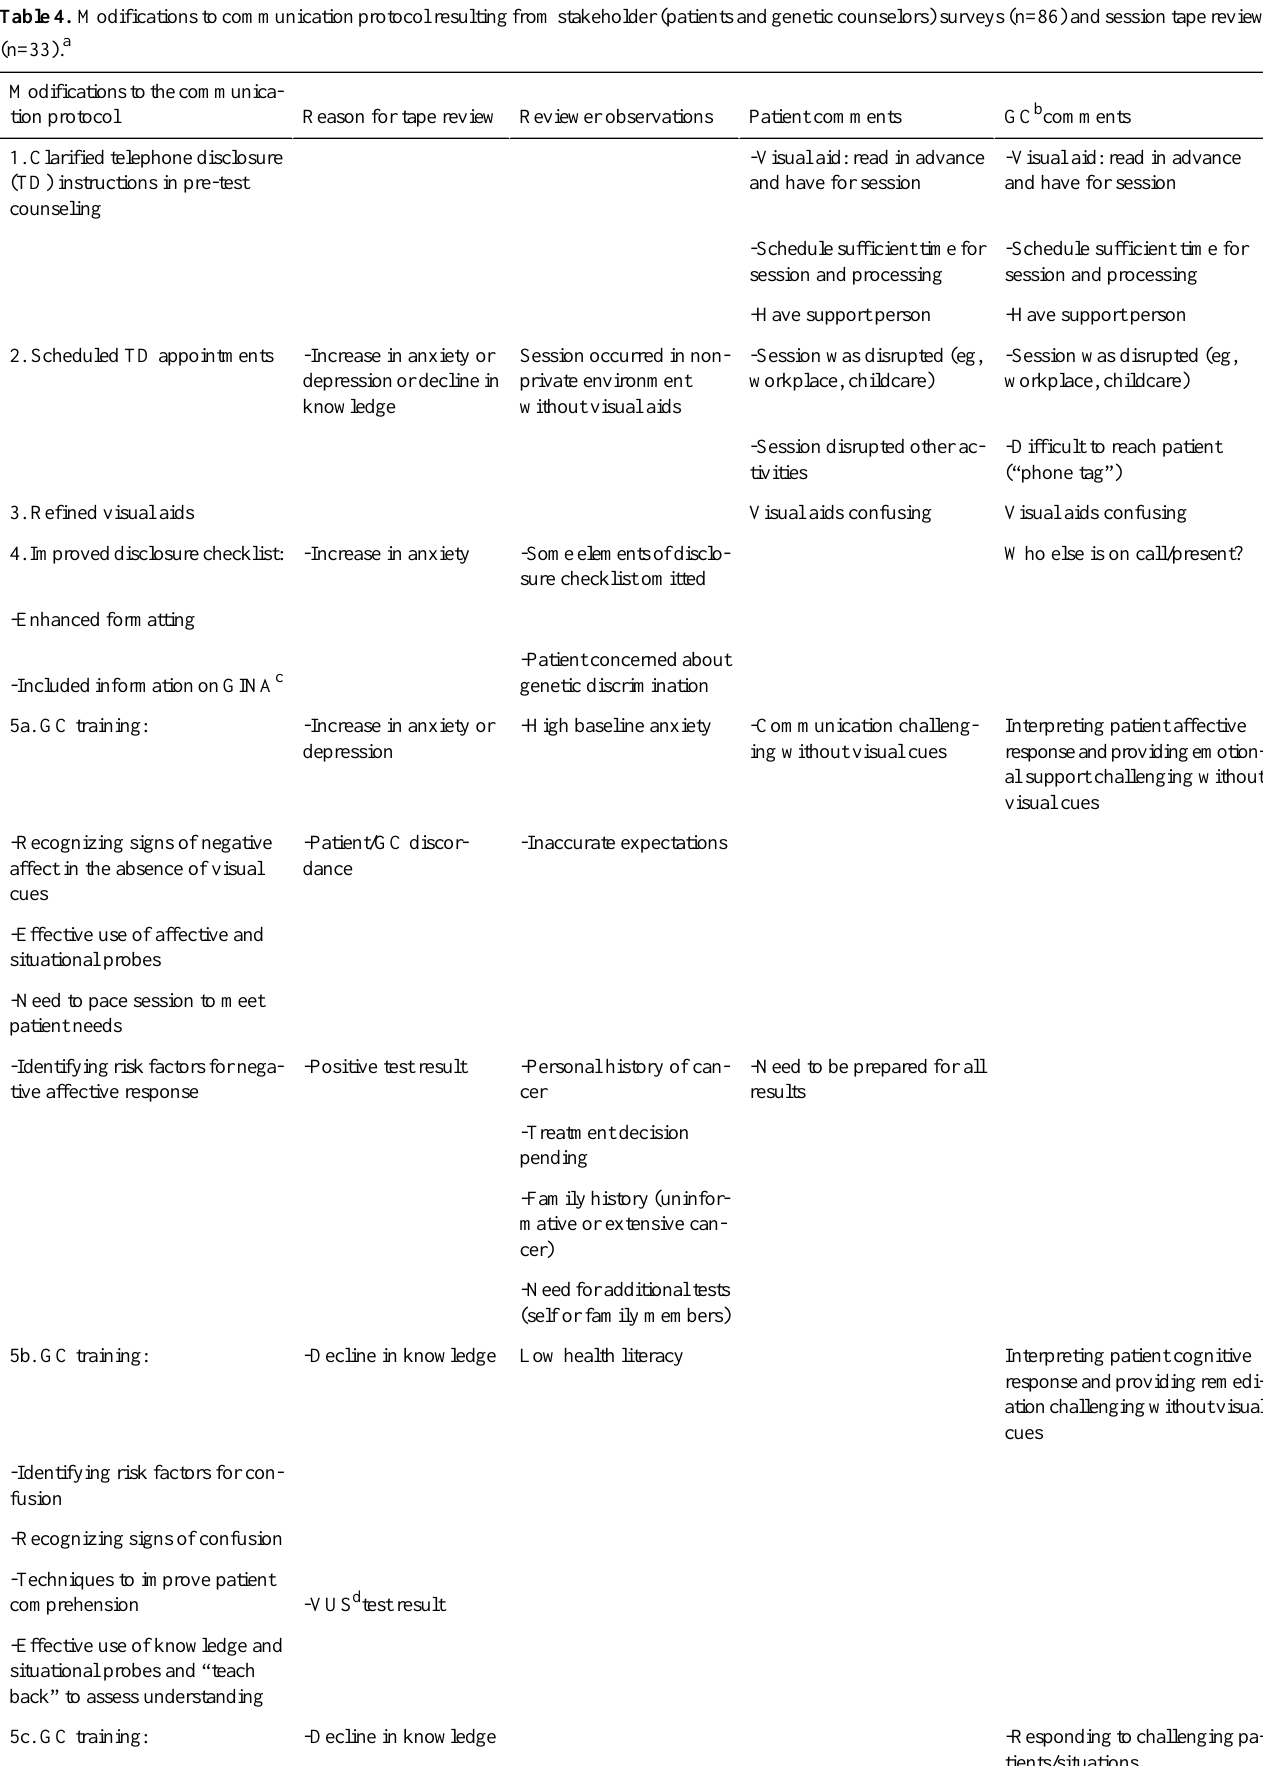
Table 4. Modifications to communication protocol resulting from stakeholder (patients and genetic counselors) surveys (n=86) and session tape reviews (n=33).